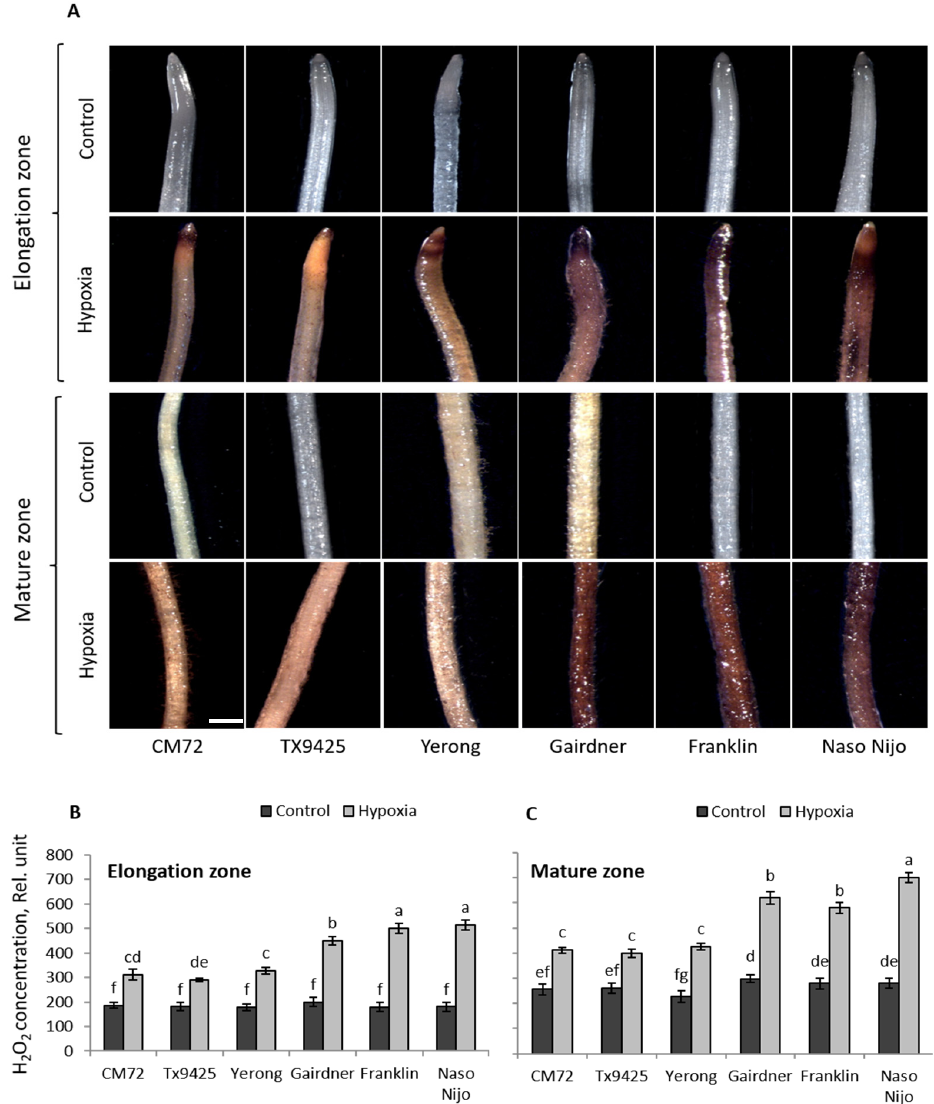
Figure 2. ( A ) Histochemical detection of hydrogen peroxide (H 2 O 2 ) in the elongation and mature zone in the roots of six barley cultivars differing in waterlogging tolerance. ( B ) Relative quantification of the (H 2 O 2 ) concentration in the elongation and ( C ) the mature root of barley. Image J software was used to calculate relative H 2 O 2 concentration by targeting the fluorescence integrated density. Data are the mean ± SE; n = 150–250; 20–30 cells analysed for at least 6–8 individual seedlings (biological replicates). The scale bar = 1 mm. Different lowercase letters indicate the significant difference at p ≤ 0.05 according to Duncan’s multiple range tests.